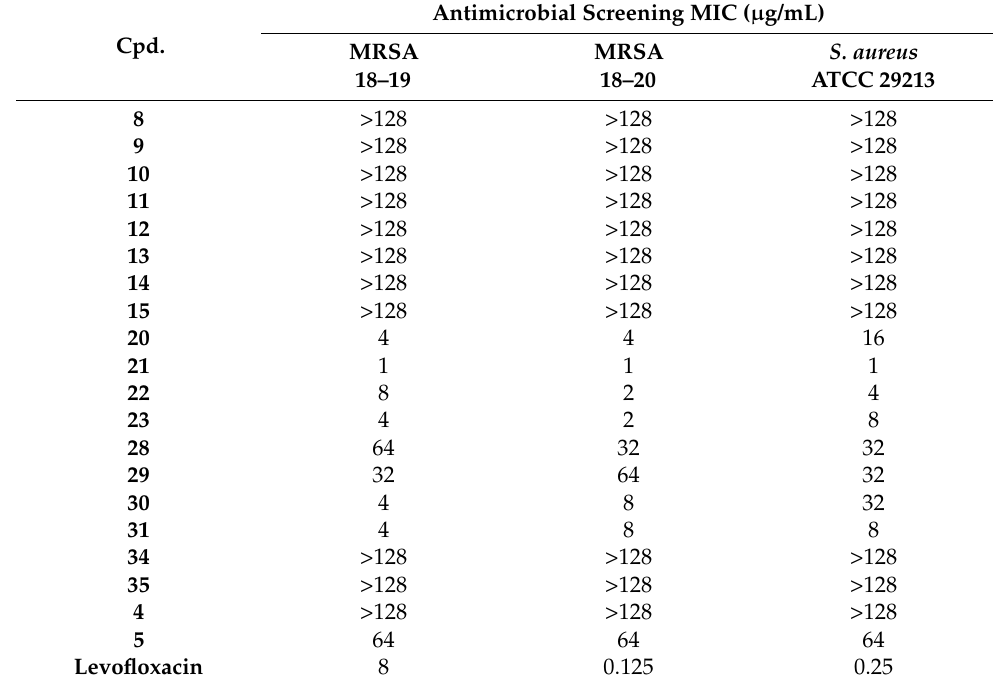
Table 1. In vitro antibacterial activity of ocotillol-type derivatives (MIC: µ g/mL).